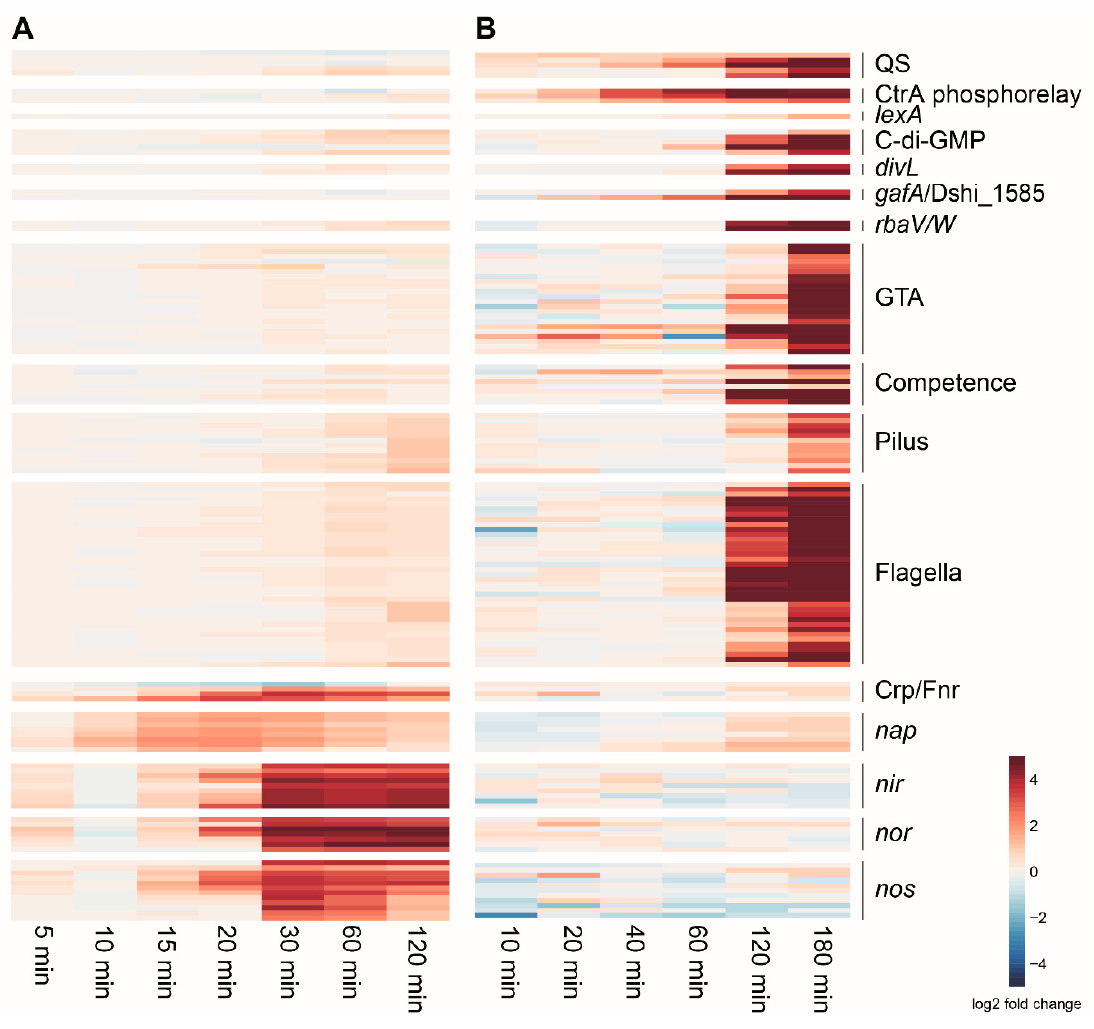
Figure 3. Time-resolved transcriptomic analysis for genes in selected groups in response to environmental changes. ( A ) Gene expression changes after the shift to anaerobic growth compared to aerobic conditions. ( B ) Gene expression after external addition of autoinducer 3-oxo C14 HSL to the QS synthase null mutant ( Δ luxI 1 ).